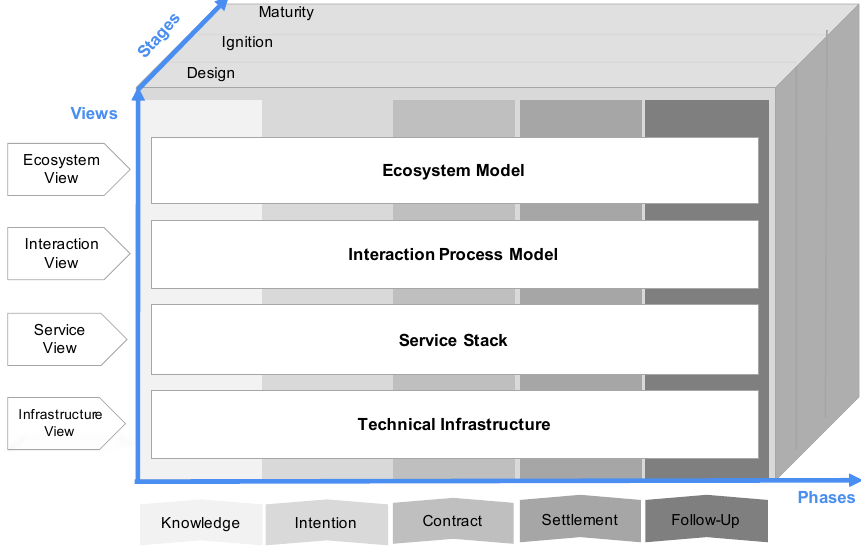
Figure 4. DMS Reference Model